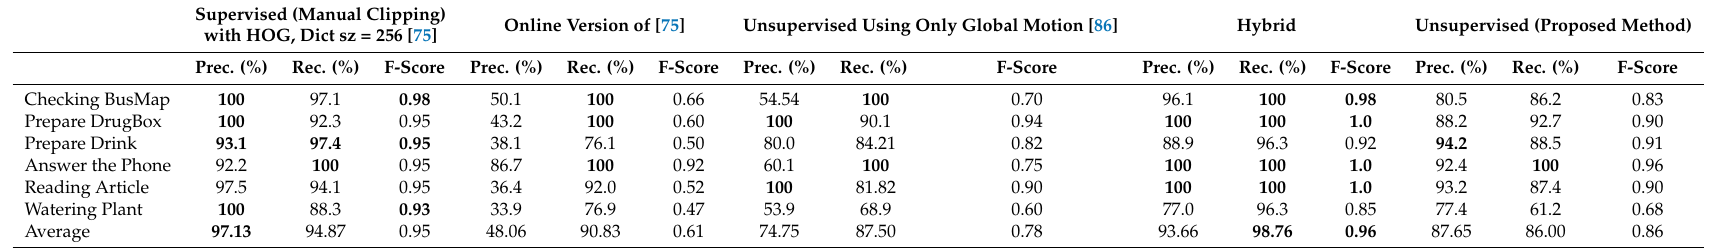
Table 4. Comparison of different recognition frameworks with ours on the CHU dataset. The table below shows the detailed results of each method with respect to each class in the dataset. The best results in each section are indicated in bold.